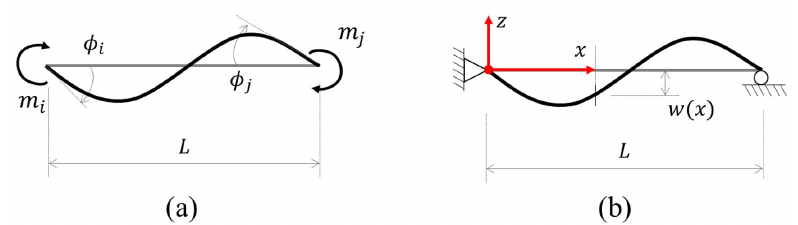
Figure 1. Deformed shape of a beam element: (a) generalised deformations and stresses; (b) transverse displacement